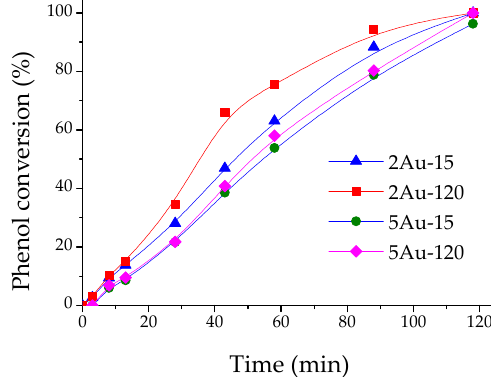
Figure 5. Catalytic activity of the prepared catalysts during the phenol photo-catalytic oxidation.